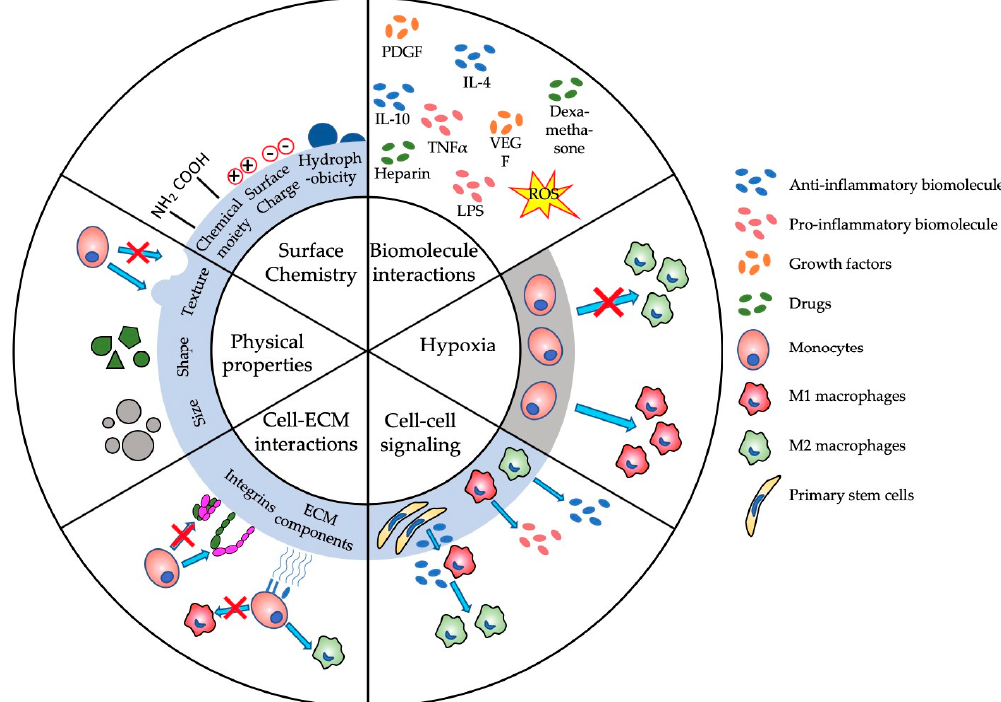
Figure 2. Schematic of major parameters that influence the immunomodulation of biomaterials and tissue engineered constructs. ECM—extracellular matrix; IL—interleukin; LPS—lipopolysaccharide; PDGF—platelet-derived growth factor; TNF α —tumor necrosis factor α ; VEGF—vascular endothelial growth factor.